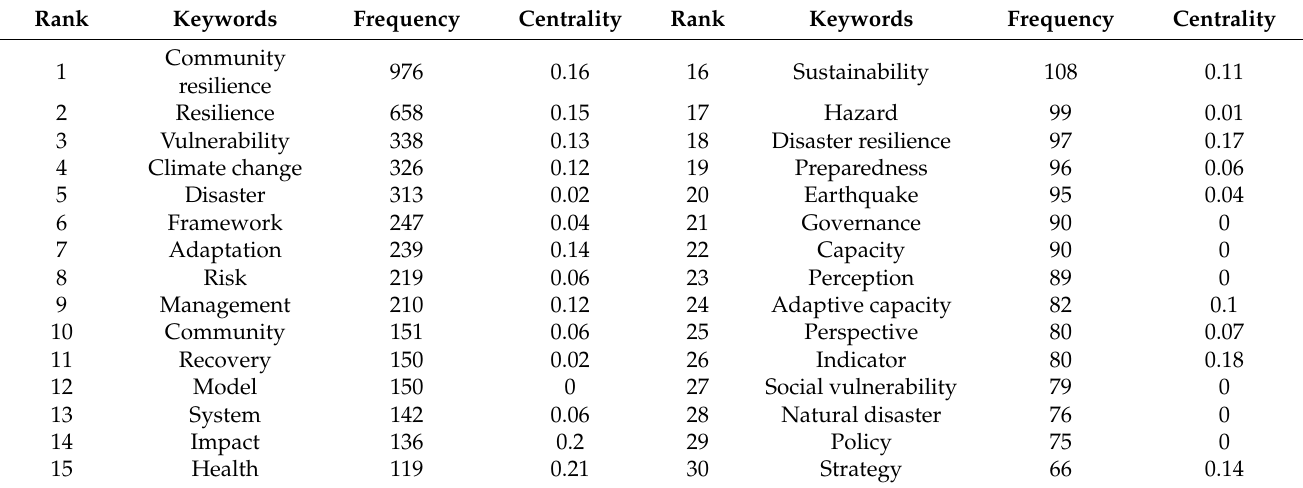
Figure 12. The cluster network mapping of high-frequency keywords. Table 8. Top 30 keywords with frequency and